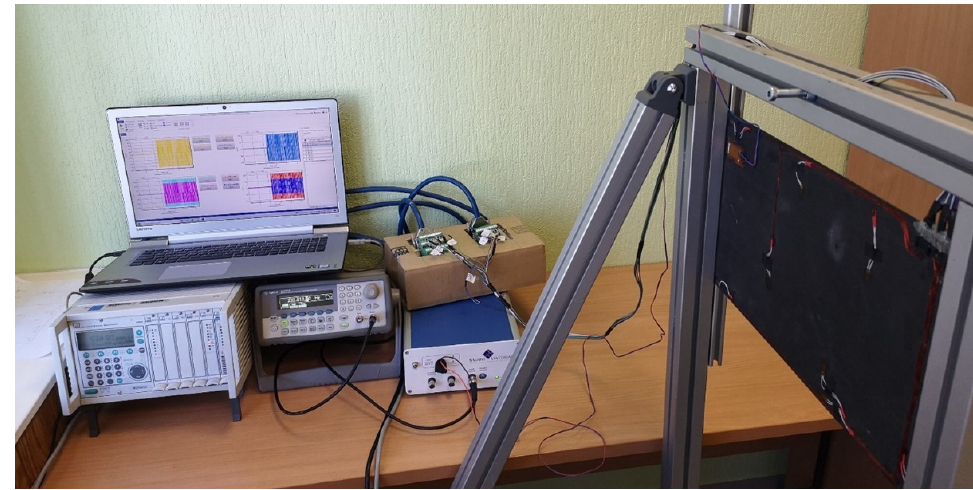
Figure 9. The experimental setup of hardware implementation of the developed SHM system [15]. Table 2. The experimental resonant frequencies (Hz) and corresponding modes.